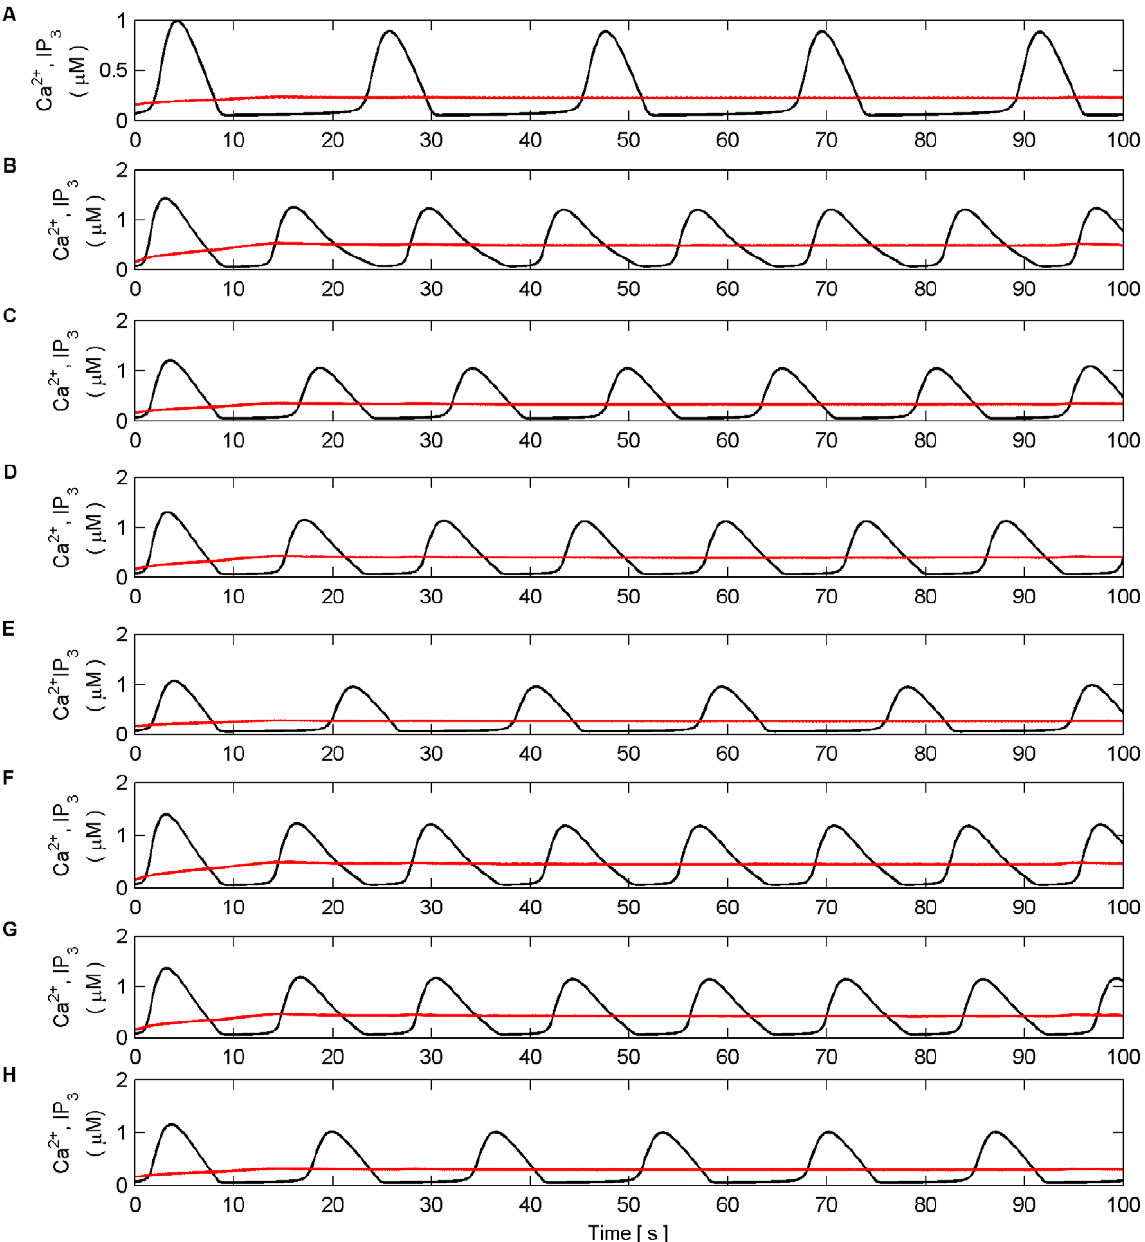
Figure 17. Individual Ca 2 + oscillations and IP 3 levels in AM-FM mode. (A–H) Individual Ca 2 + oscillations (black), IP 3 transients (red) in each of the 8 microdomains associated with the synapses of N1 (A–D) and N2 (E–H). The input stimulus to each microdomain is a Poisson spike train with an average frequency of (A) 2 Hz, (B) 10 Hz, (C) 5 Hz, (D) 7 Hz, (E) 3 Hz, (F) 9 Hz, (G) 8 HZ, (H) 4 Hz. Note that there is no noticeable phase locking of the individual Ca 2 +